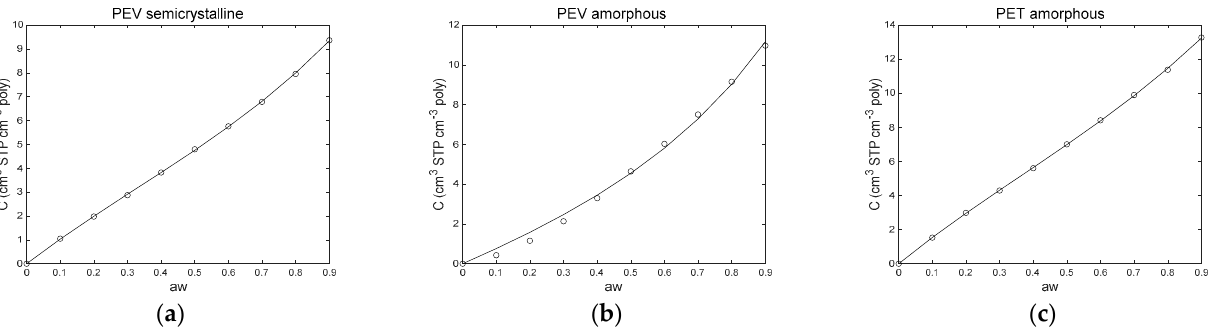
Figure 6. New dual mode sorption model fitting on ( a ) semicrystalline PEV water vapor sorption isotherm; ( b ) amorphous PEV water vapor sorption isotherm and ( c ) amorphous PET sorption data from the study of Dubelley et al. [10] .